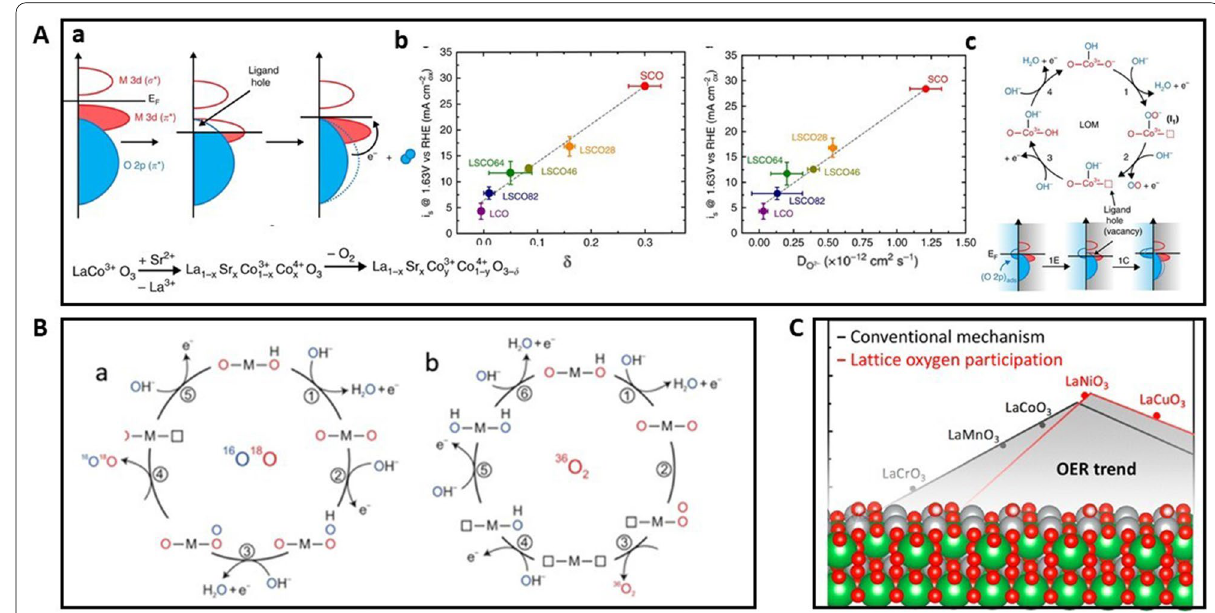
Fig. 16 A (a) Illustration of oxygen vacancy concentration and Co–O bond covalency. (b) Relationship between oxygen vacancies, oxygen diffusivity, and the OER activity. (c) The proposed LOM mechanism (Figure reprinted with permission from Ref. [73]). B Possible OER mechanisms involving concerted proton‑electron transfer on surface oxygen sites to yield (a) 34 O 2 ( 16 O 18 O), and (b) 36 O 2 ( 18 O 18 O), respectively (Figure reprinted with permission from Ref. [68]). C Volcano plot for OER on some perovskites with AEM and LOM (Figure reprinted with permission from Ref.